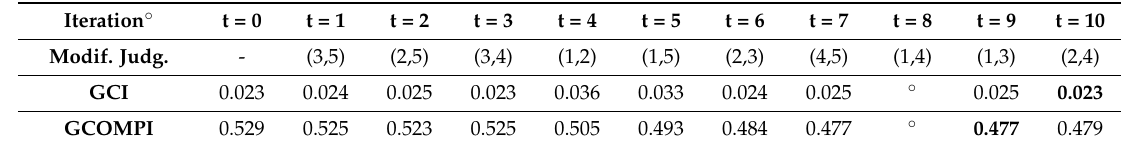
Table 9. Results for the iterative procedure with θ = 0 (the best value of the methods is in bold, for each